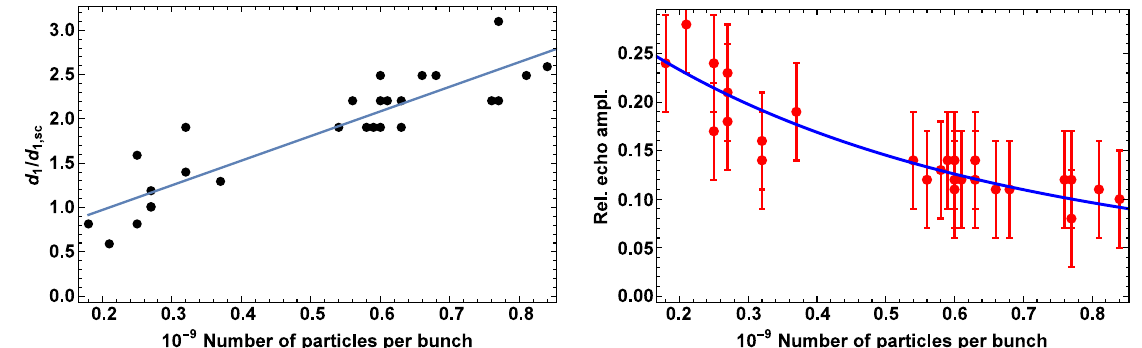
FIG. 9. Left: Calculated d 1 values as a function of the number of particles per bunch and the linear fit to the values. Right: Measured relative echo amplitude (red) at different intensities and compared with the best fit curve (blue) with ð D 1 ; D 2 Þ , with D1 from the linear fit in the left plot and D2 independent of the bunch